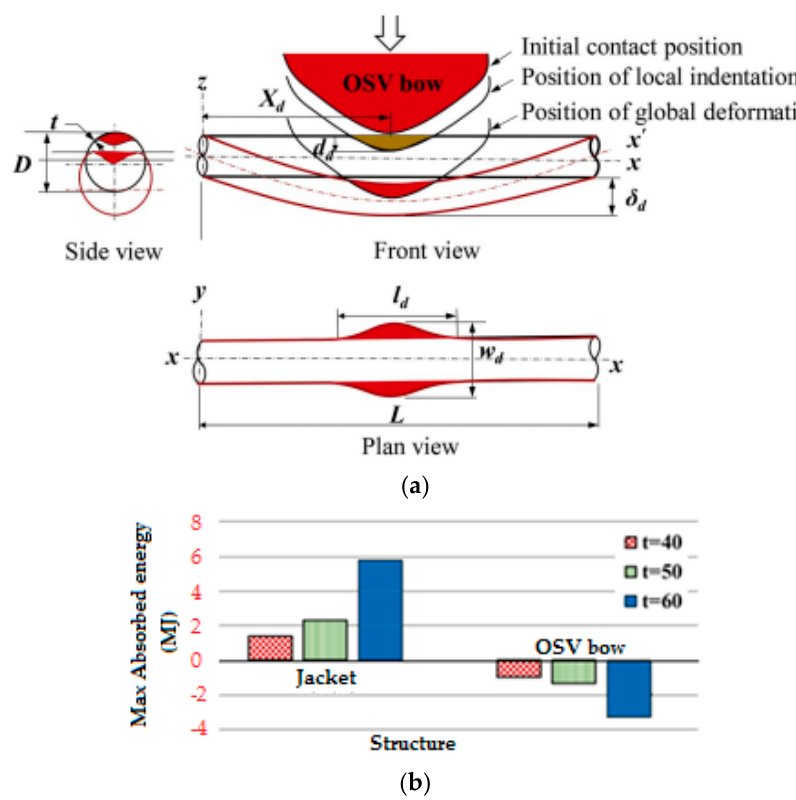
Figure 10. The collision’s effects of the OSV’s bow and jacket structure on absorbed energy and a deformed tubular member [49]. ( a ) A schematic diagram showing local denting and overall bending of a tubular, ( b ) Difference in maximum absorbed energy.